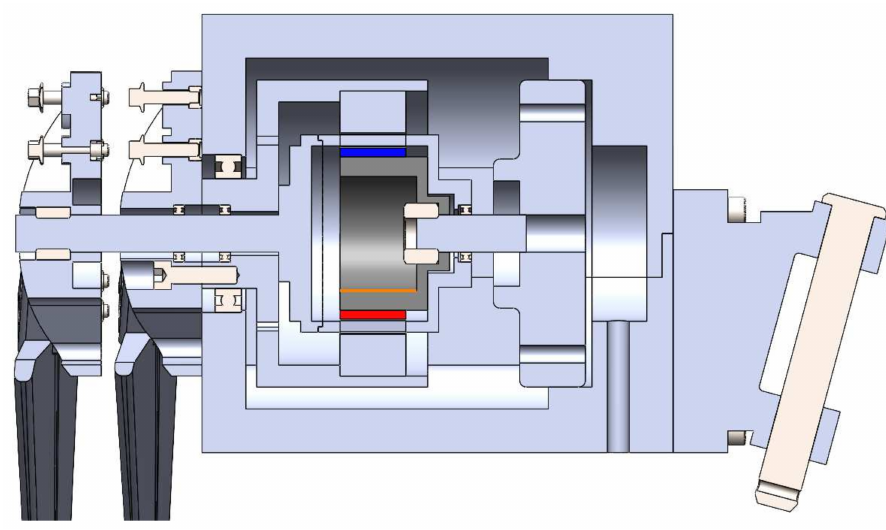
Figure 17. Sectional view of the developed SWT.